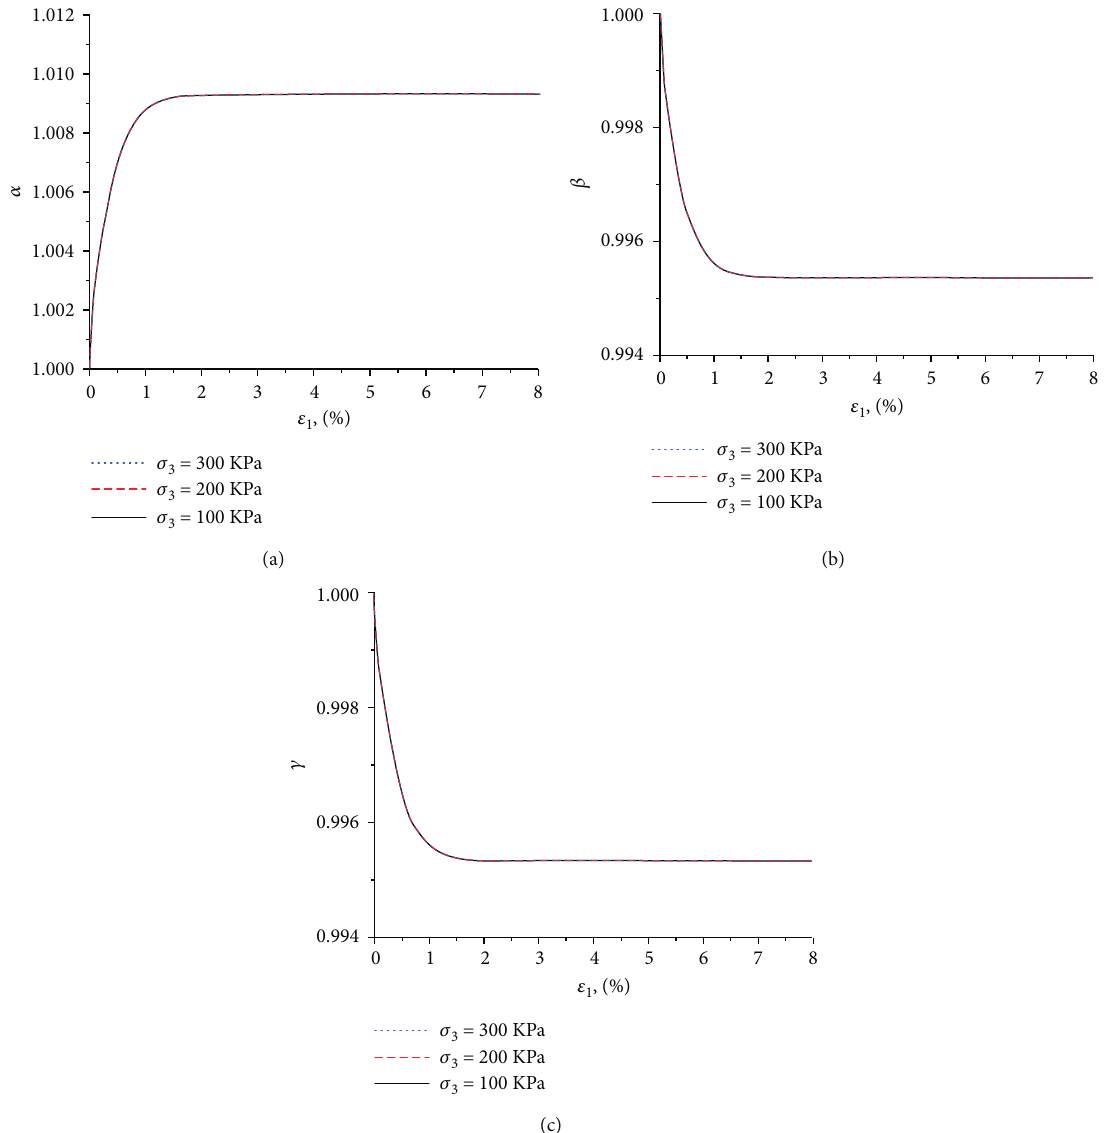
Figure 8: Changes of anisotropic parameters for various con fi ning pressure: (a) α vs. axial strain; (b) β vs. axial strain; (c) γ vs. axial